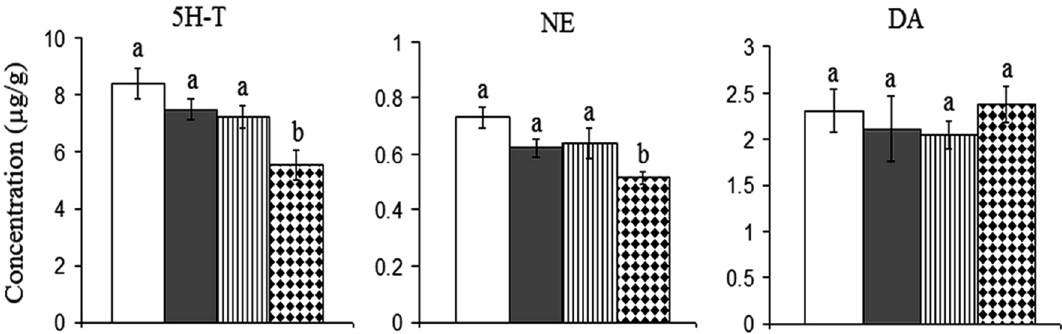
Figure 10. Effect of different doses of green synthesized silver nanoparticles (AgNPs) (0.5 mg/kg, 5 mg/kg, and 10 mg/kg) on the levels of serotonin (5H-T), norepinephrine (NE), and dopamine (DA) in the cortex of rat brain. Control, Rats treated with AgNPs (0.5 mg/kg), Rats treated with AgNPs (5 mg/kg), Rats treated with AgNPs (10 mg/kg). Statistically significant means (p-value < 0.05) are given different letters and the same letters indicate non-significant